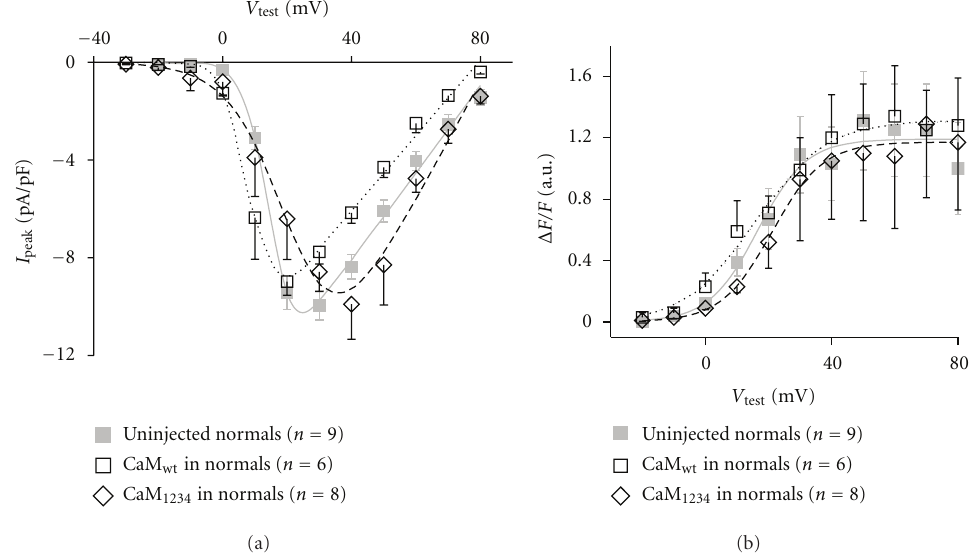
Figure 1: Ca 2+ -binding ability of CaM does not a ff ect skeletal muscle EC coupling. (a) The average peak current density ( I peak ) is plotted as a function of membrane potential ( V test ). Data were obtained from the indicated number of myotubes for each group. The smooth lines through the data were generated by using equation (1) (see Methods) and the average values. (b) The average peak fluorescence ( Δ F/F ) is plotted as a function of membrane potential ( V test ). Data were obtained from the indicated number of myotubes for each group. The smooth lines through data represent Boltzmann fits to the average data using equation (3) (see